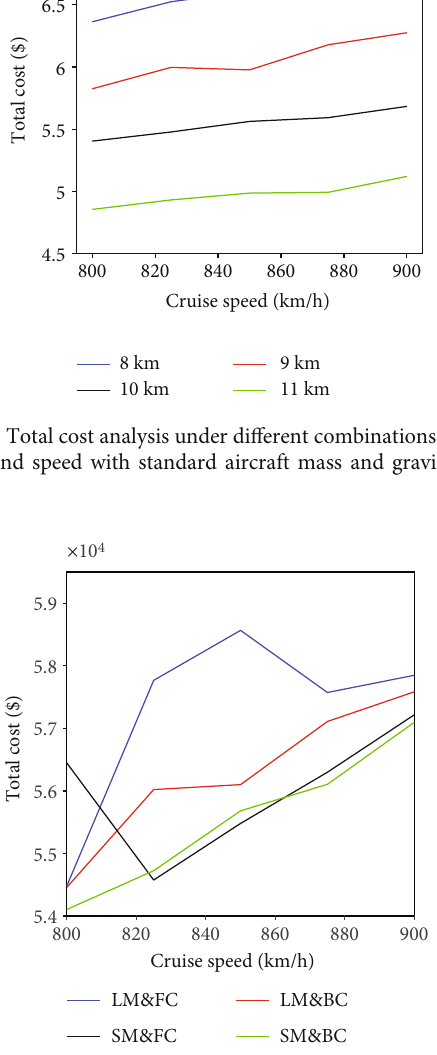
Figure 9: “ Cruise speed and total cost ” analysis under di ff erent combinations of aircraft mass and gravity center position with standard cruise